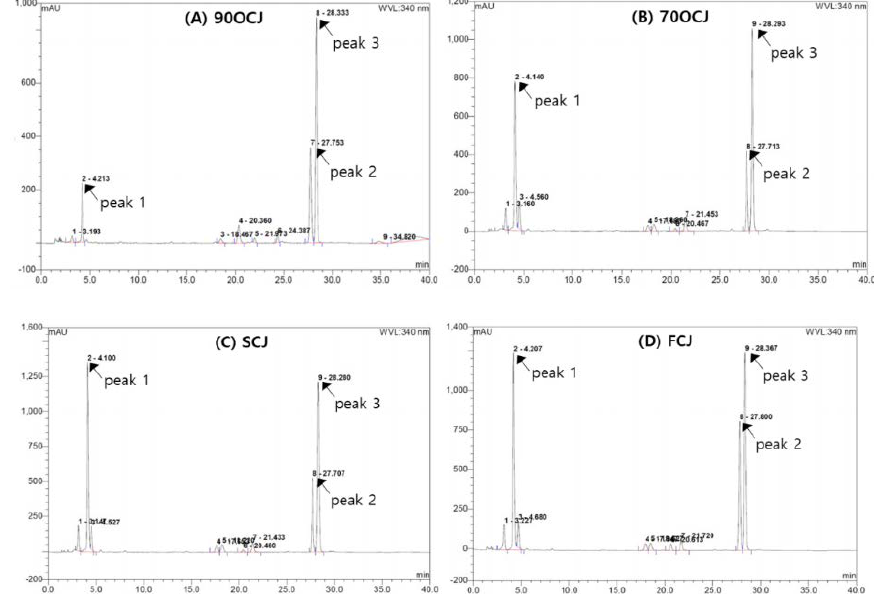
Figure 1. High performance chromatography profiles on phenolic compounds of CJ extracts that are